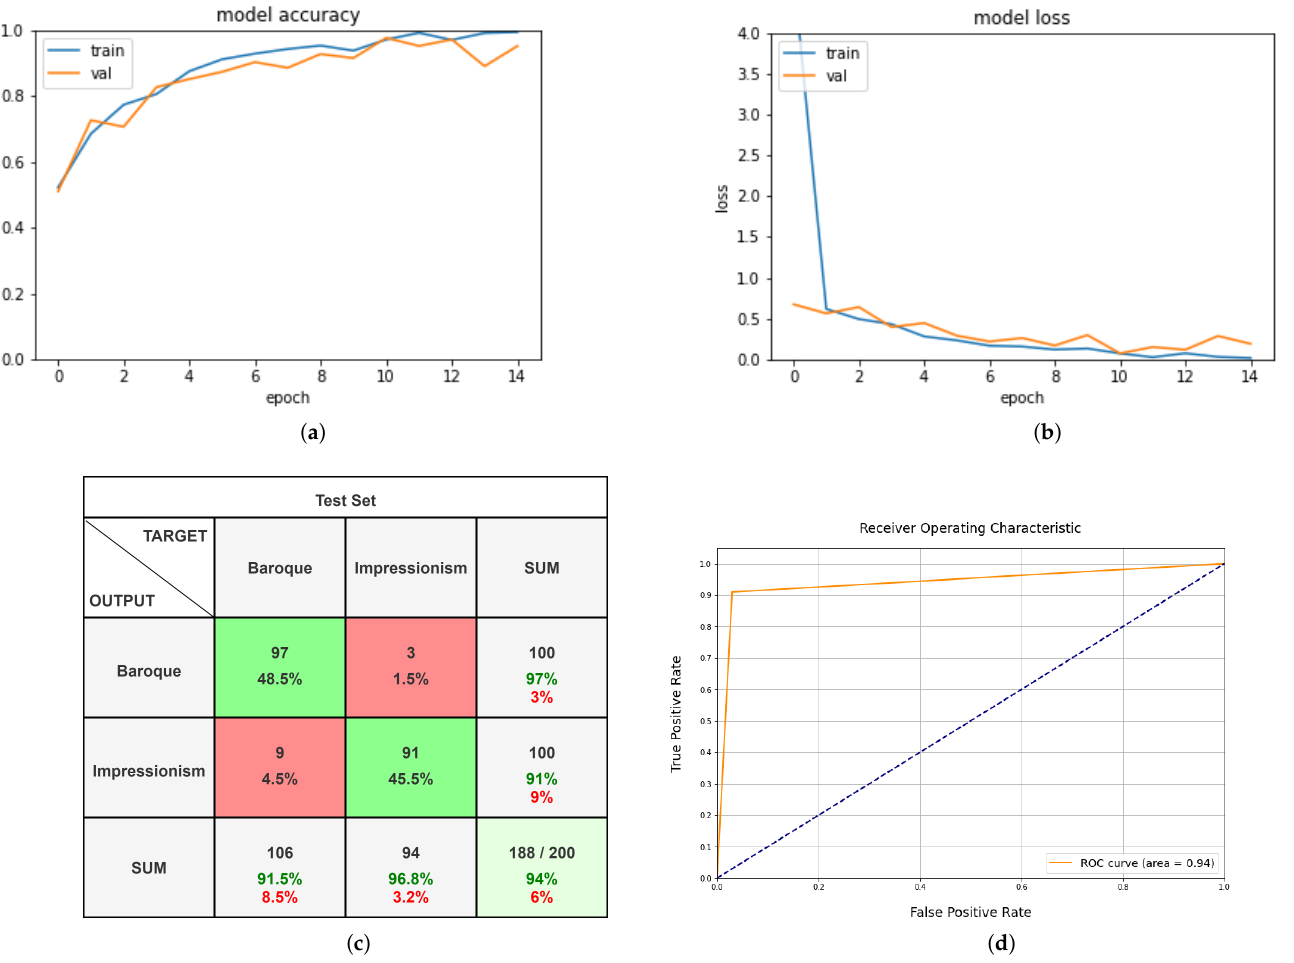
Figure 12. Confusion matrix and statistical analysis of the paintings dataset analysed on Custom- CNN with Google Colab. ( a ) Accuracy function; ( b ) loss function; ( c ) confusion matrix paintings test set; ( d ) receiver operating characteristic